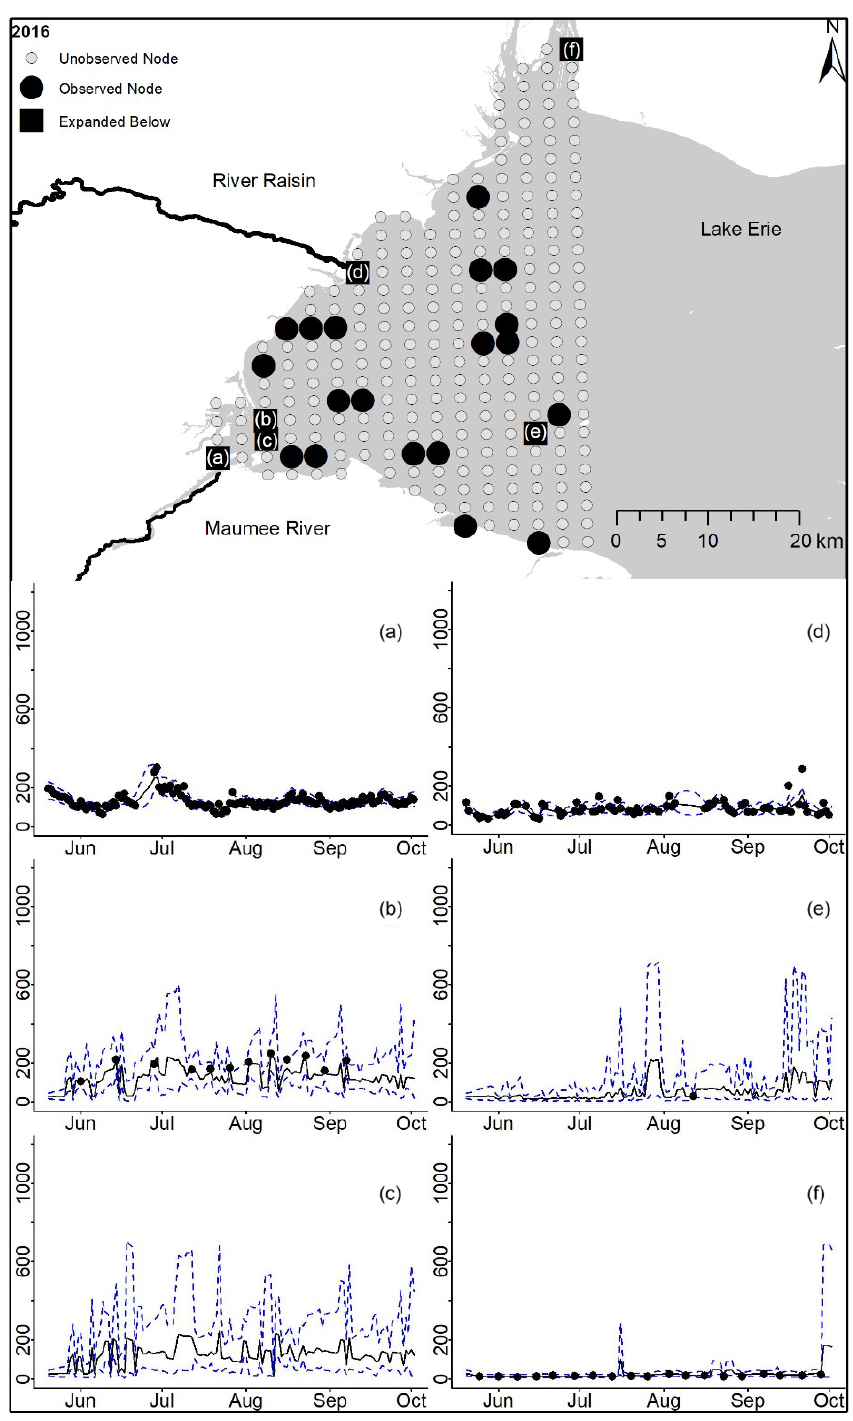
Figure D9. For 2016 the total phosphorus concentrations (µgL − 1 ) at observed and unobserved nodes were estimated from the model posterior samples. Mean (solid black line) and 95%PI (dashed blue line) for the model posterior samples of each node at every day for (a) the Maumee River, (b, c, e, f) western Lake Erie nodes, and (d) the Raisin